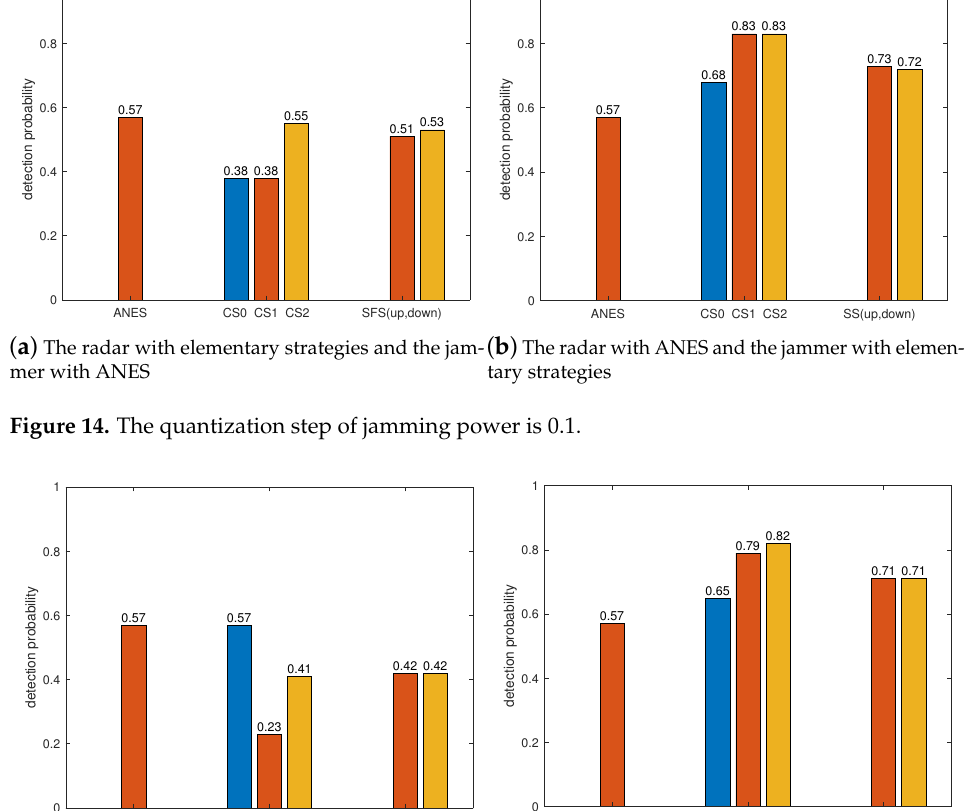
( b ) The radar with ANES and the jammer with ele- mentary strategies